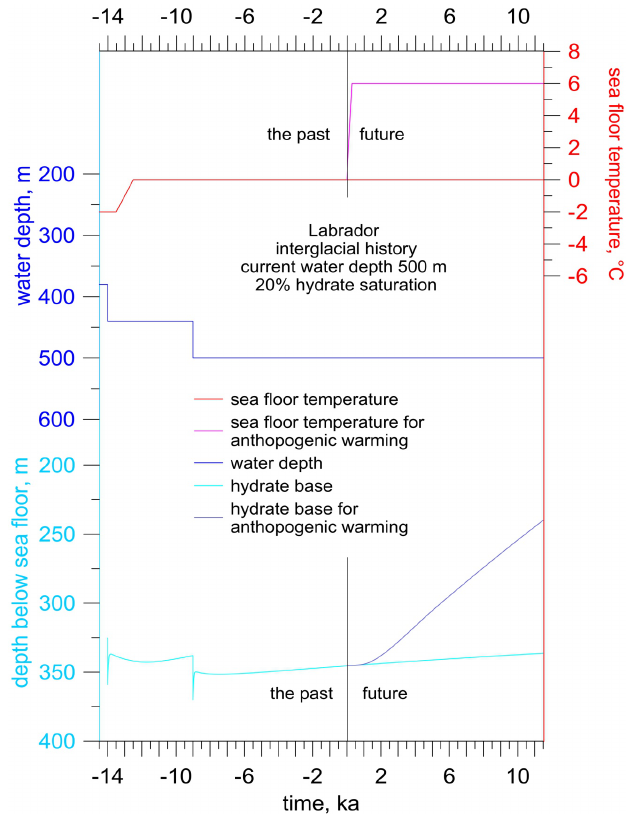
Figure 11. Labrador Sea GH history models for current a 500 m water